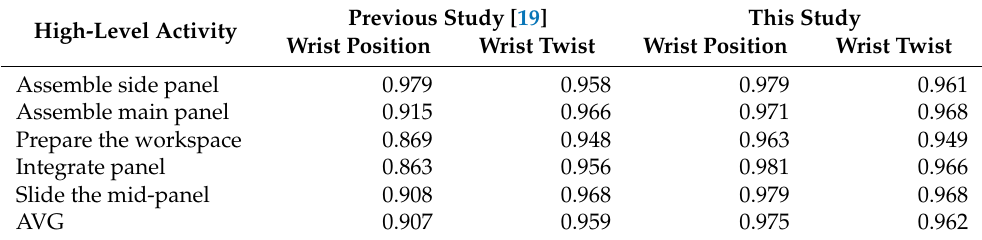
Table 7. Previous study similarity measurement results for wrist section.